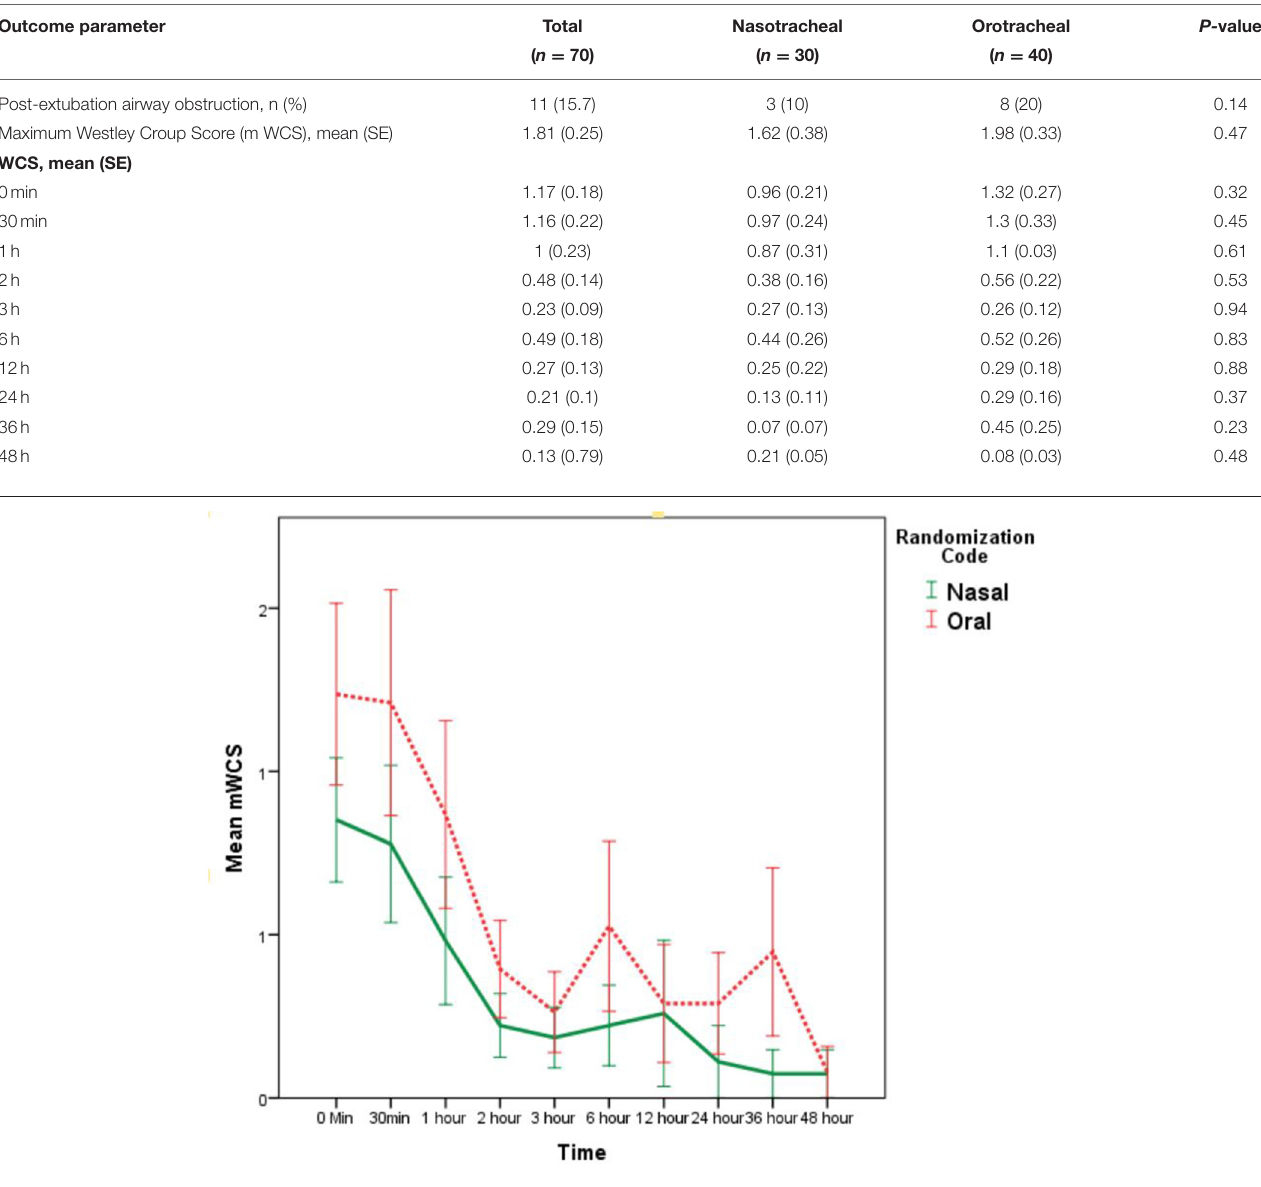
TABLE 2 | Primary outcomes in nasotracheal and orotracheal intubation groups. Outcome parameter Total Nasotracheal Orotracheal